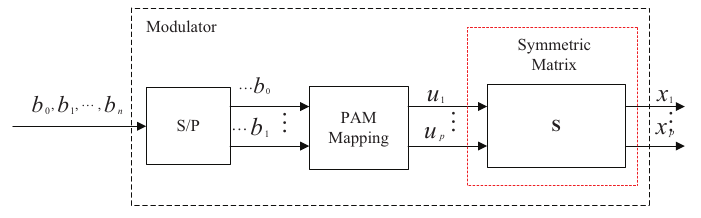
Figure 2. The symmetric matrix-aided